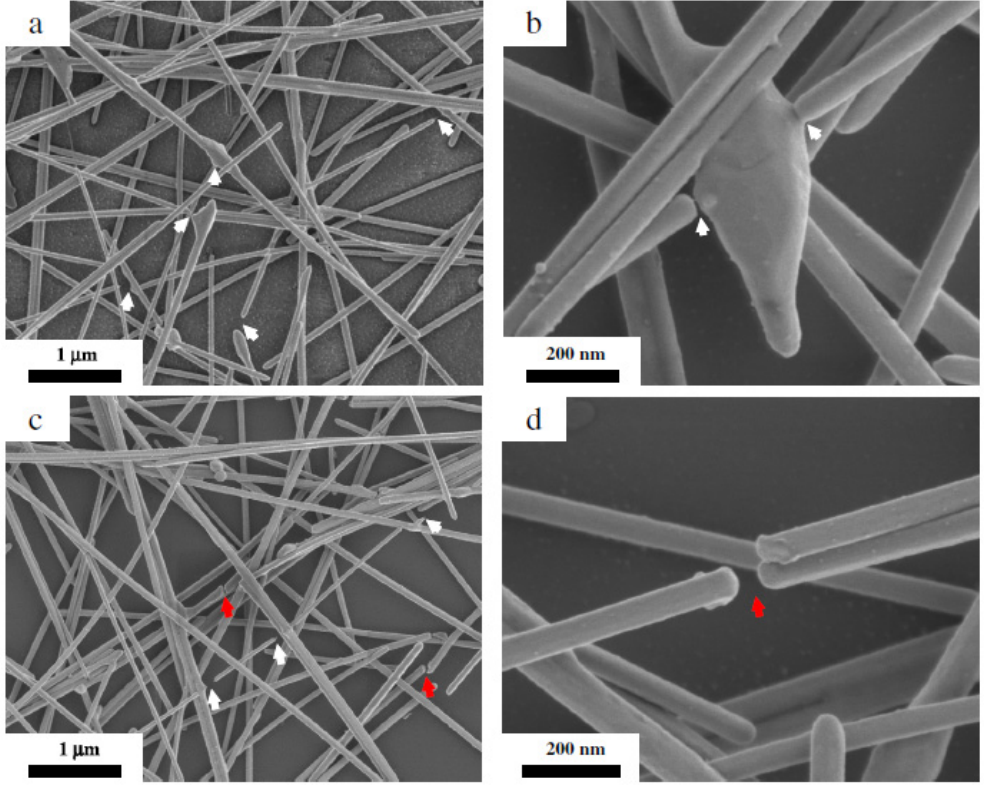
Figure 12. SEM images of silver nanowire networks after 400,000 cycles of bending ( a , b ) under tensile strain and ( c , d ) under compressive strain. Reproduced with permission from ref. [43]. Copyright 2016, Elsevier.